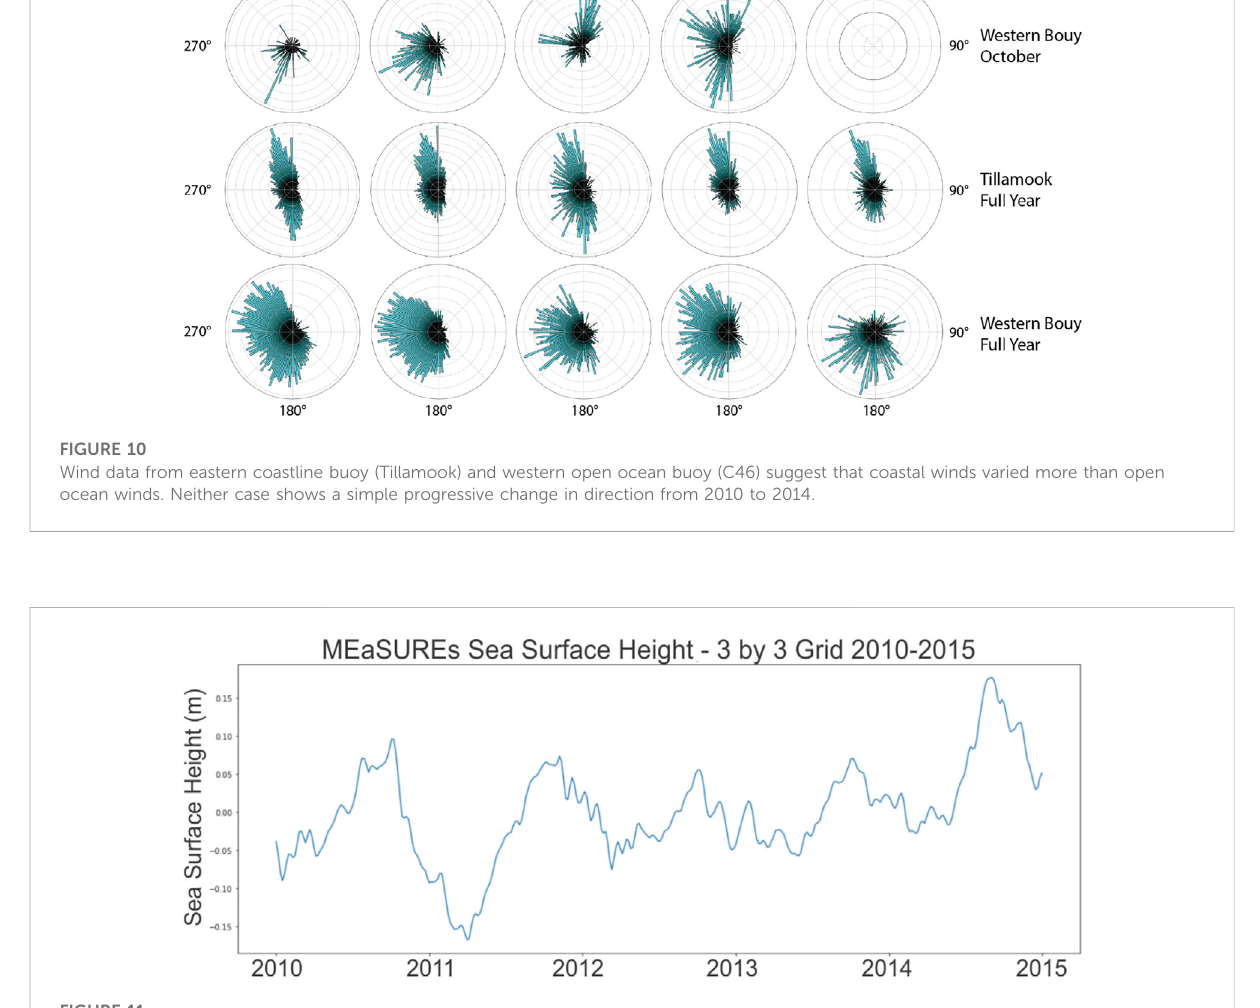
FIGURE 11 Seasurfaceheight(SSH)overtheMainEndeavourField(MEF)isshownfor2010to2015.DatadownloadedfromNASAPODAAC(seeTable1and footnotes). Implications for interpreting the observed changes in plume